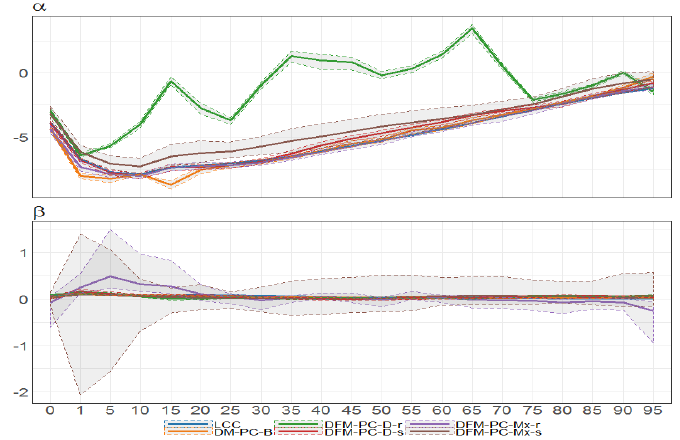
Figure 30. Bayesian posterior estimators with 95% posterior credible intervals for the estimation of α and β under different models (colours of lines) for British female mortality data